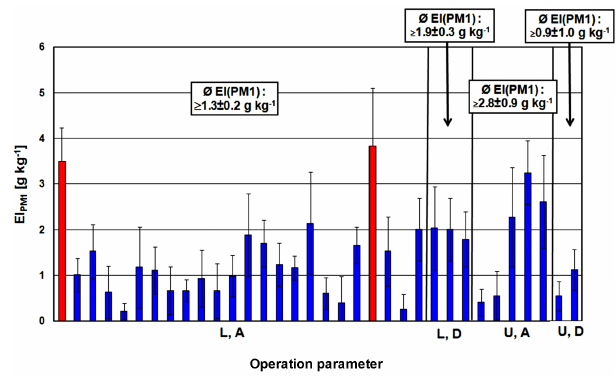
Figure 7. Lower limit EI PM ships [goods] and the weighted average EI PM eration parameters, L = loaded, U = unloaded, A = upstream and D =